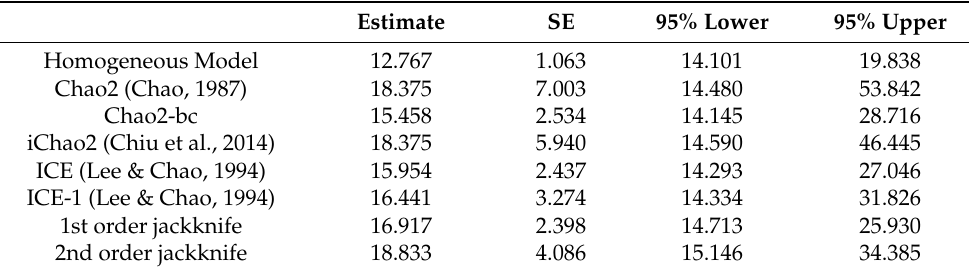
Table 2. Species richness estimation based on the observed species presence/absence data.